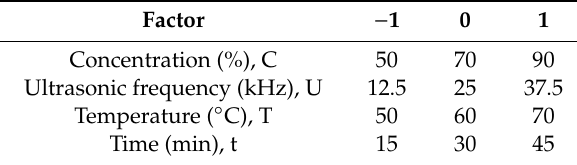
Table 1. Levels in full factorial experiments for TMA and TPC from grape pomace. Factor − 1 0 1 Concentration (%), C